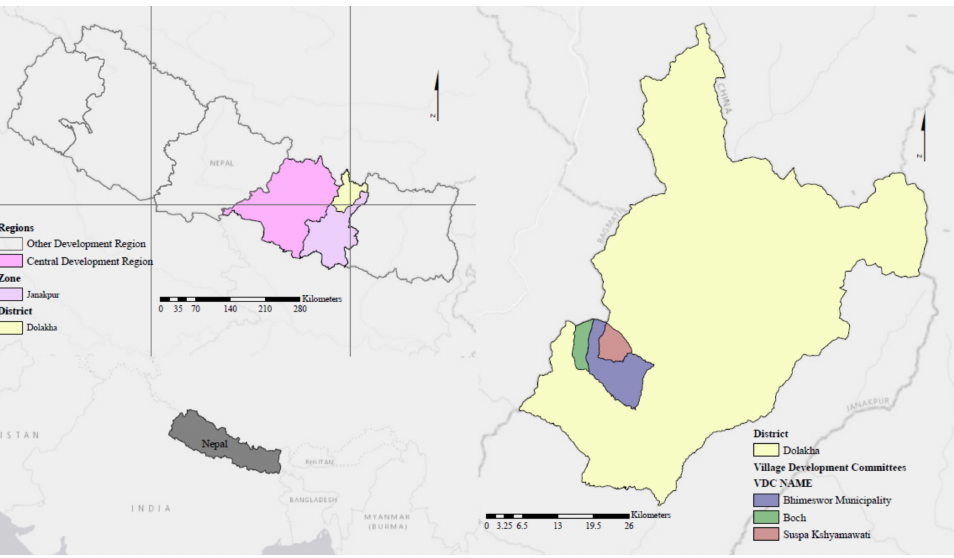
Figure 2. Dolakha district,